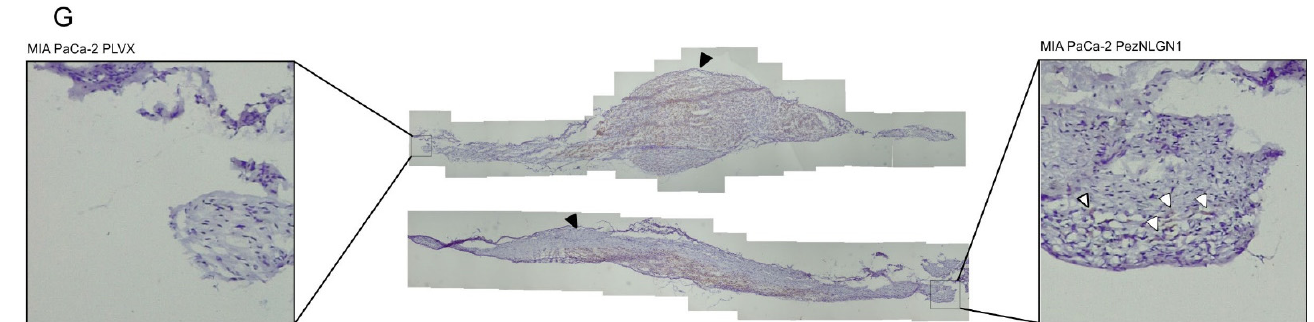
Figure 2 . NLGN1 triggers cell invasion along the nerves in an ex vivo and in vivo models of peri- neural invasion. ( A ) Co-culture of murine DRG with prostate (PC3 shCTR or PC3 shNLGN1 cells, upper panels) and pancreatic cancer cells (MIA PaCa-2 PLVX or PezNLGN1 cells, lower panels). Pictures were taken at 48 h and are representative of 1 of 3 reproducible experiments performed in quadruplicate (original magnification 2.5 × ). ( B ) Quantification of the invasion rate. Values are mean ± SE of 3 independent experiments. Unpaired Student’s t -test, two tailed: **, p < 0.01, ***, p < 0.001. ( C – G ) 3 × 10 5 PC3 shCTR and PC3 shNLGN1 ( C , D ), or MIA PaCa-2 PLVX and MIA PaCa-2 PezNLGN1 ( E – G ) cells, further infected with a CMV-Luc vector, were surgically inoculated into the right sciatic nerve of 6-week-old NOD/SCID mice. IVIS images shown in ( C , E ) are represen- tative of 1 of 6 mice. Graphs in ( D , F ) show the evaluation of the length (mm) of the bioluminescence of tumor cells along the sciatic nerve over time. Values are expressed as mean ± SE, n = 6. Unpaired Student’s t -test, two tailed: *, p < 0.05 **, p < 0.01, ***, p < 0.001. ( G ) Cytokeratin staining (brown) by IHC on two sciatic nerves that were injected either with control or NLGN1-overespressing MIA PaCa-2 cells, and next surgically extracted at the endpoint. The cellular distribution of cells in the main tumor is visible (the site of tumor cell injection indicated by the black arrowheads), while distally migrating tumor cells (shown in the magnification by white arrowheads) are visible only with NLGN1-overexpressing MIA PaCa-2